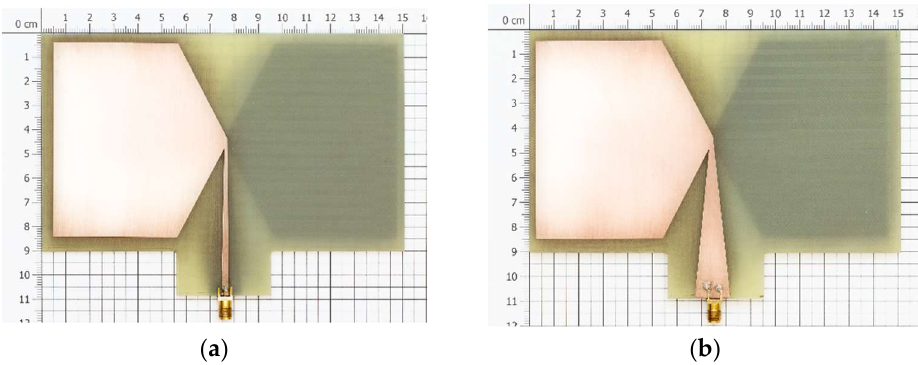
Figure 10. Fabrication shape of the biconical antenna: ( a ) front view, ( b ) back view.